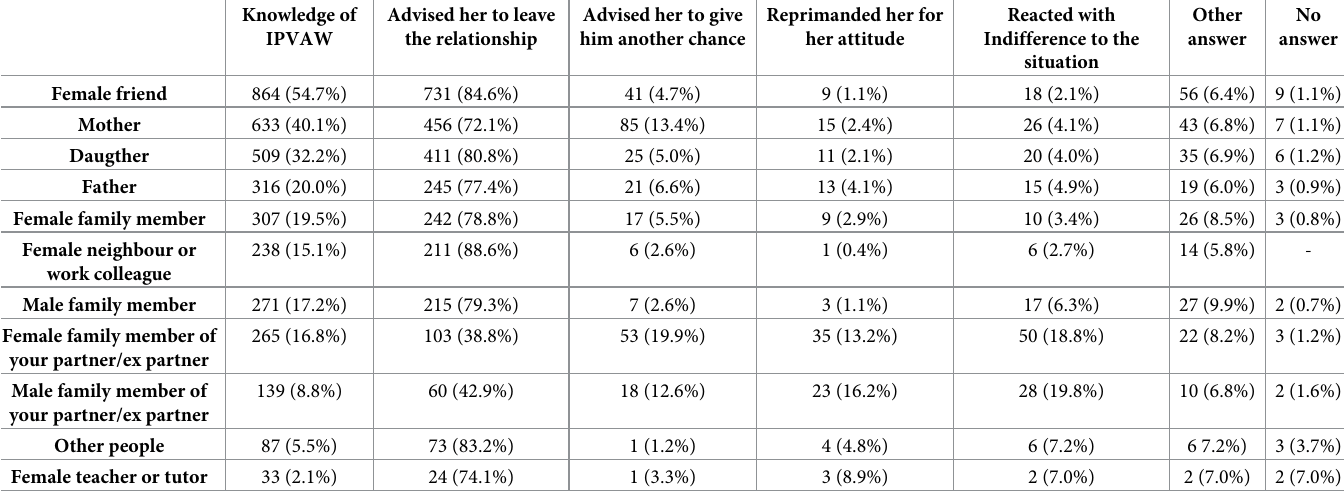
Table 3. Knowledge of IPVAW within the victim’s inner circle and their reactions. Macro–survey 2014 (n = 1,279). Knowledge of Advised her to leave IPVAW the